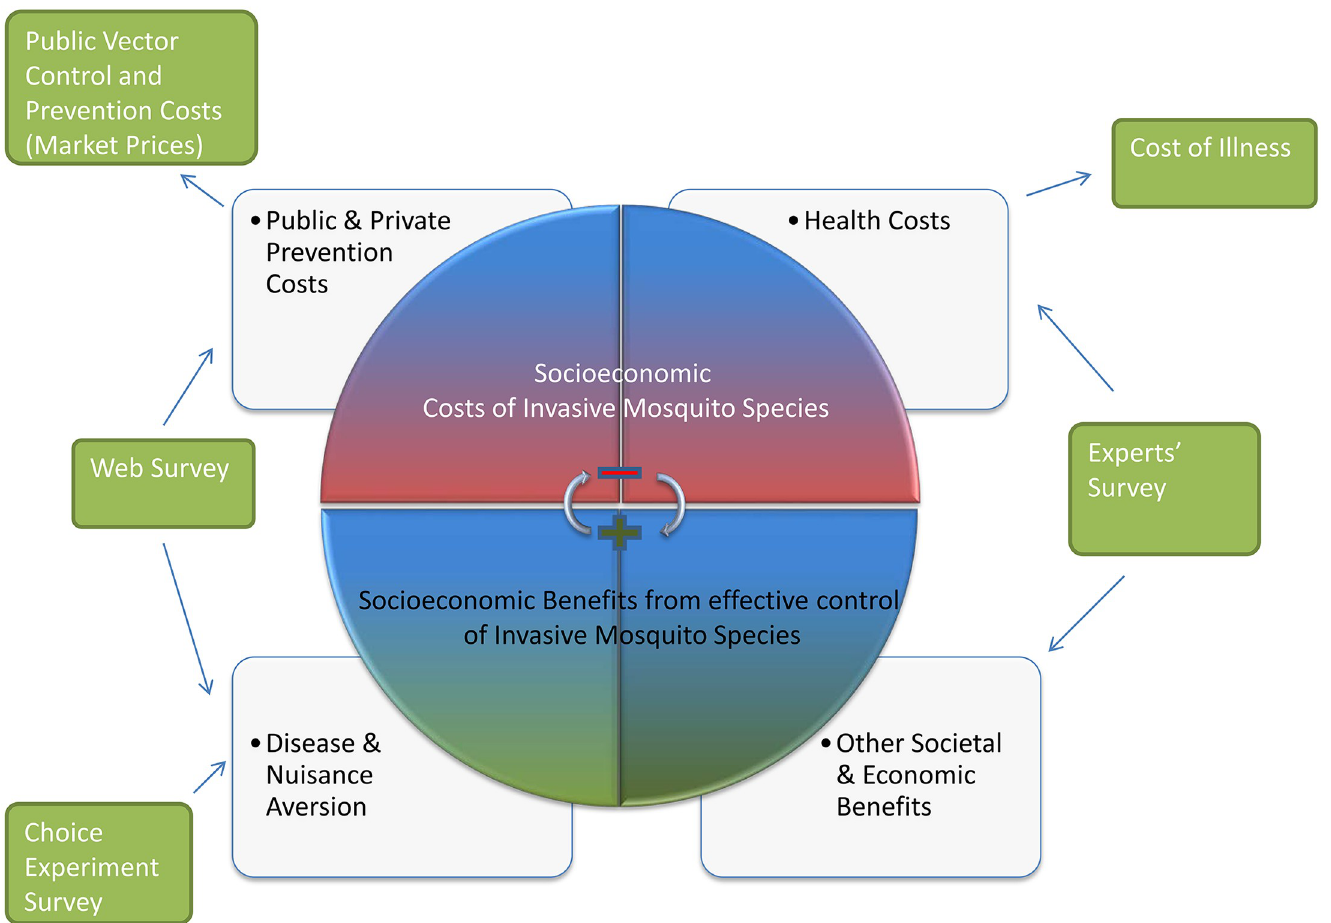
Fig 1. The different methods employed for the estimation of socioeconomic costs and benefits associated with the problem of invasive mosquito